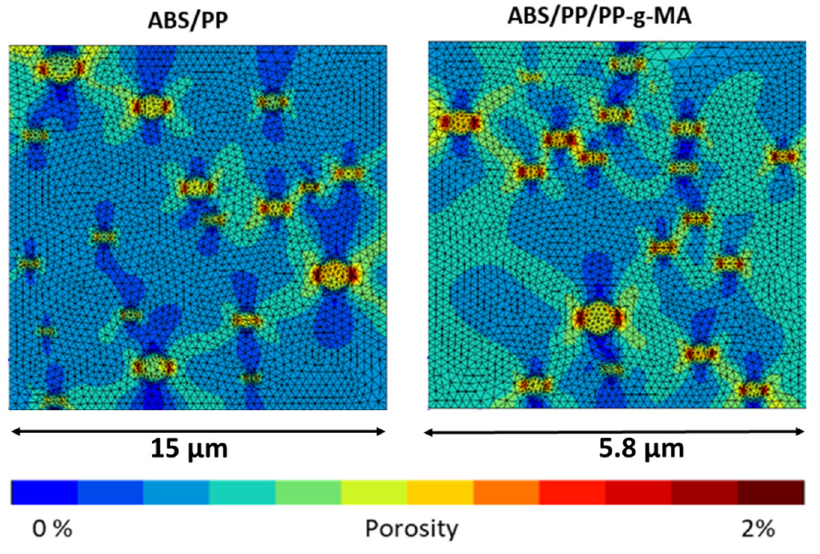
Figure 20. Porosity cartography at 1.7% of macroscopic strain in ABS/PP and ABS/PP/PP-g-MA composites.